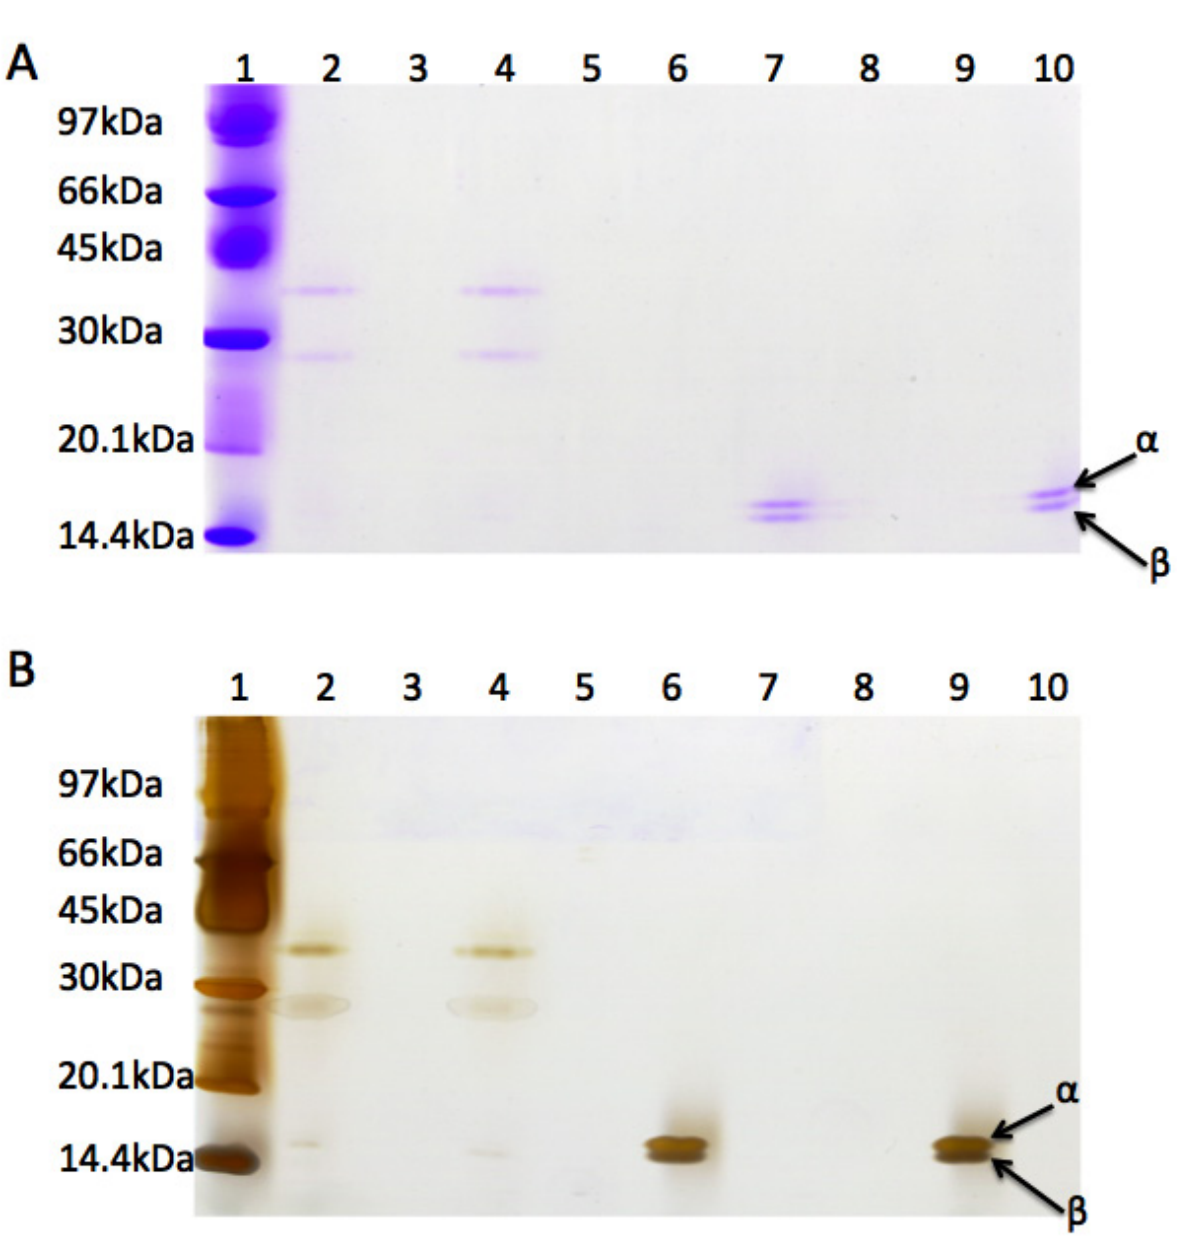
Figure 3. Homogeneity of purified rhodocetin from DP2 assessed using 15% SDS-PAGE. The purified rhodocetin showed two distinct bands due to separation of the heterodimer into its α and β subunits by SDS denaturation. The separated bands were visualized with both ( A ) Coomasie brilliant blue and ( B ) silver staining. ( A ) Lane 1: GE Healthcare low molecular weight (LMW) markers; lane 2: DP1; lane 3: blank; lane 4: DP1; lanes 5 and 6: blank; lane 7: DP2; lanes 8 and 9: blank; lane 10: DP2. ( B ) Lane 1: GE Healthcare LMW markers; lane 2: DP1; lane 3: blank; lane 4: DP1; lane 5: blank; lane 6: DP2; lanes 7 and 8: blank; lane 9: